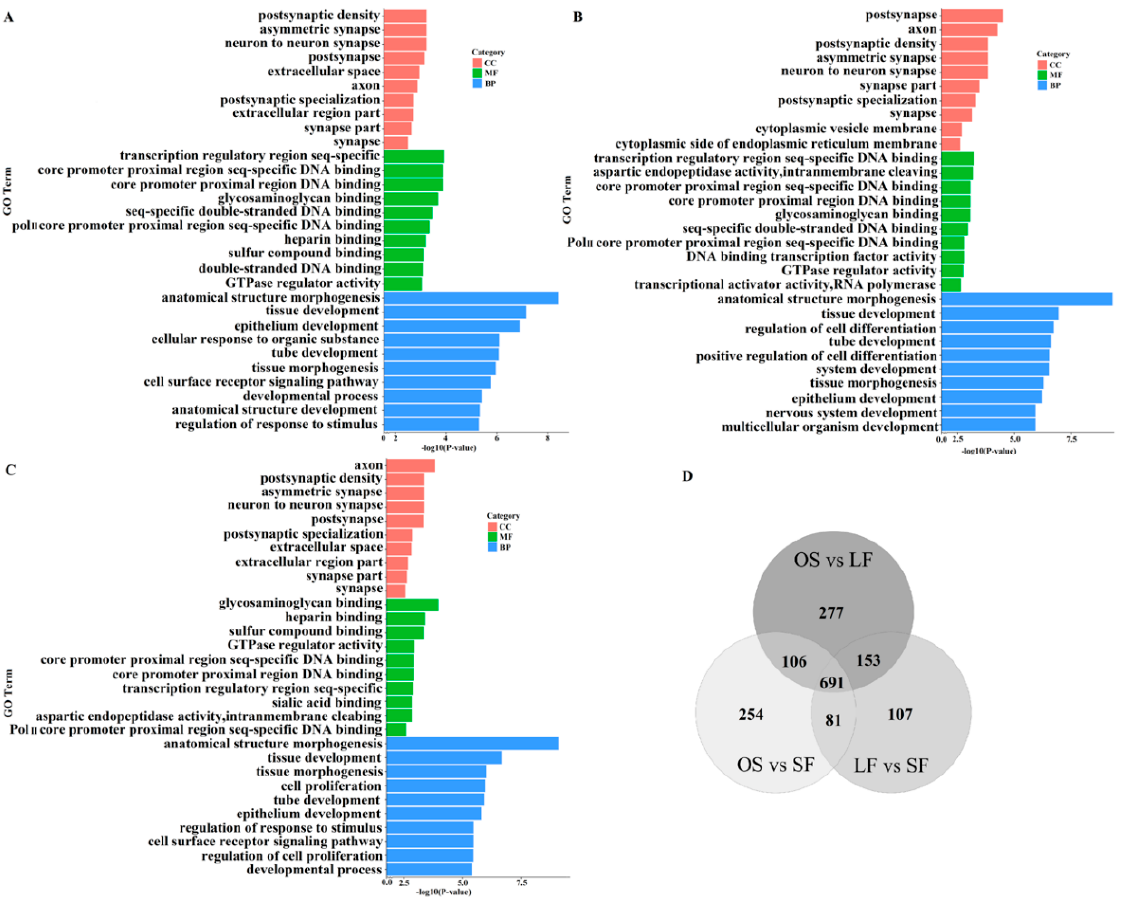
Figure 5. GO functional enrichment analyses of the DEmiRNAs. ( A ) Top 10 differential GO terms of target genes from each category in OS vs. LF, ( B ) in OS vs. SF, and ( C ) in LF vs. SF. ( D ) Venn diagram of GO terms in OS vs. LF, OS vs. SF, and LF vs. SF.